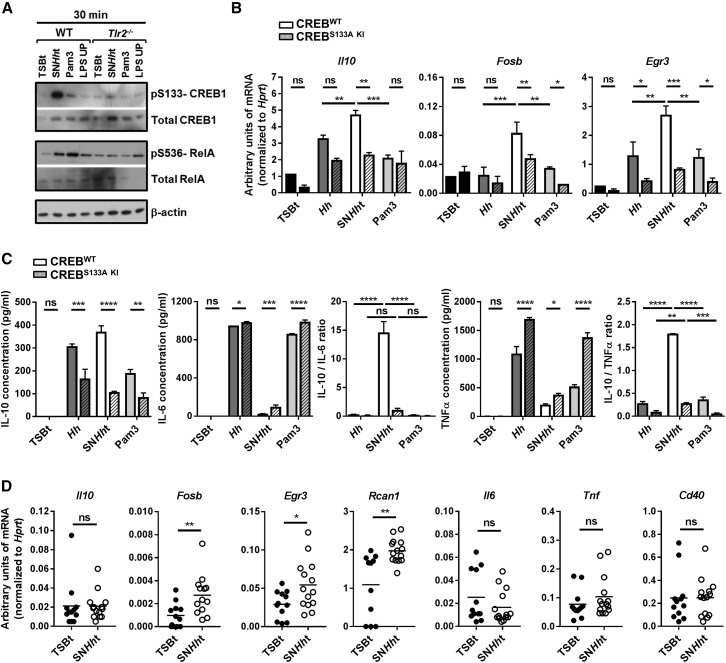
SNHht Stimulates CREB Phosphorylation and Induction of an Anti-inflammatory and Repair Gene Signature in Macrophages(A) Western blot showing the phosphorylation of CREB1 S133 and RelA S536 and the total CREB1 and RelA protein amounts in WT and Tlr2−/− BMDMs after 30 min stimulation with TSBt, SNHht, Pam3, or LPS UP. β-actin used as a loading control.(B) mRNA levels of Il10, Fosb, and Egr3 genes in BMDMs from conditional vav-cre CREBWT and CREBS133A KI mice after 1 hr stimulation with TSBt, Hh, SNHht, or Pam3.(C) Induction of IL-10, IL-6, and TNFα; IL-10/IL-6; and IL-10/TNFα protein ratios in BMDMs from conditional vav-cre CREBWT and CREBS133A KI mice after 10 hr stimulation with TSBt, Hh, SNHht, or Pam3. One of three independent experiments. Two-way ANOVA and Sidak’s and/or Tukey’s multiple comparisons tests, p < 0.05.(D) mRNA levels of Il10, Fosb, Egr3, Rcan1, Il6, Tnf, and Cd40 genes in caecum total tissue from WT mice gavaged with TSBt or SNHht for 2 days. Each symbol represents an individual mouse (two independent experiments). Mann-Whitney test, p < 0.05.Mean ± SD. See also Figure S5.